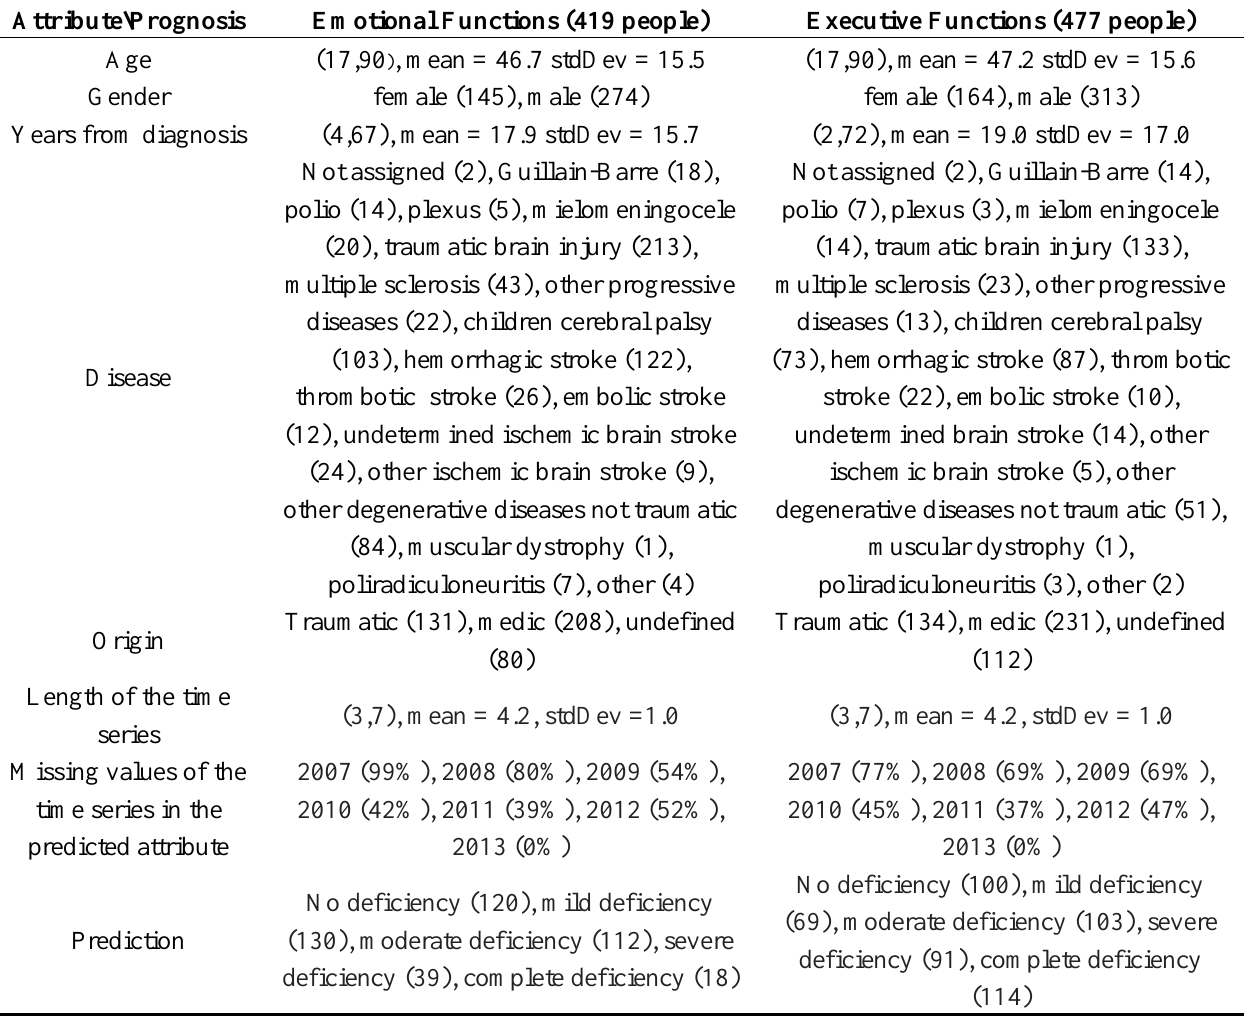
Table 1. Demographic and clinical data of the prognosis of disabilities of neurological origin with acquired brain injury (ABI) in the clinical decision support system (CDSS).